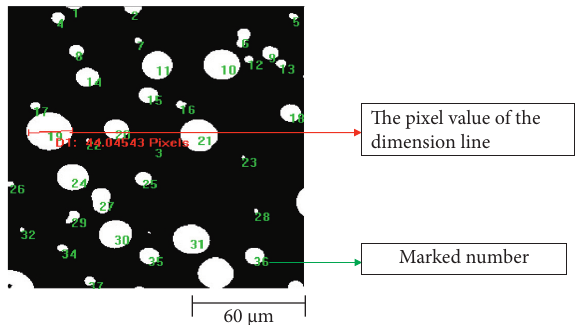
Figure 10: Fluorescence microscopic binarization image of SBS modified asphalt with 5% content of APR.